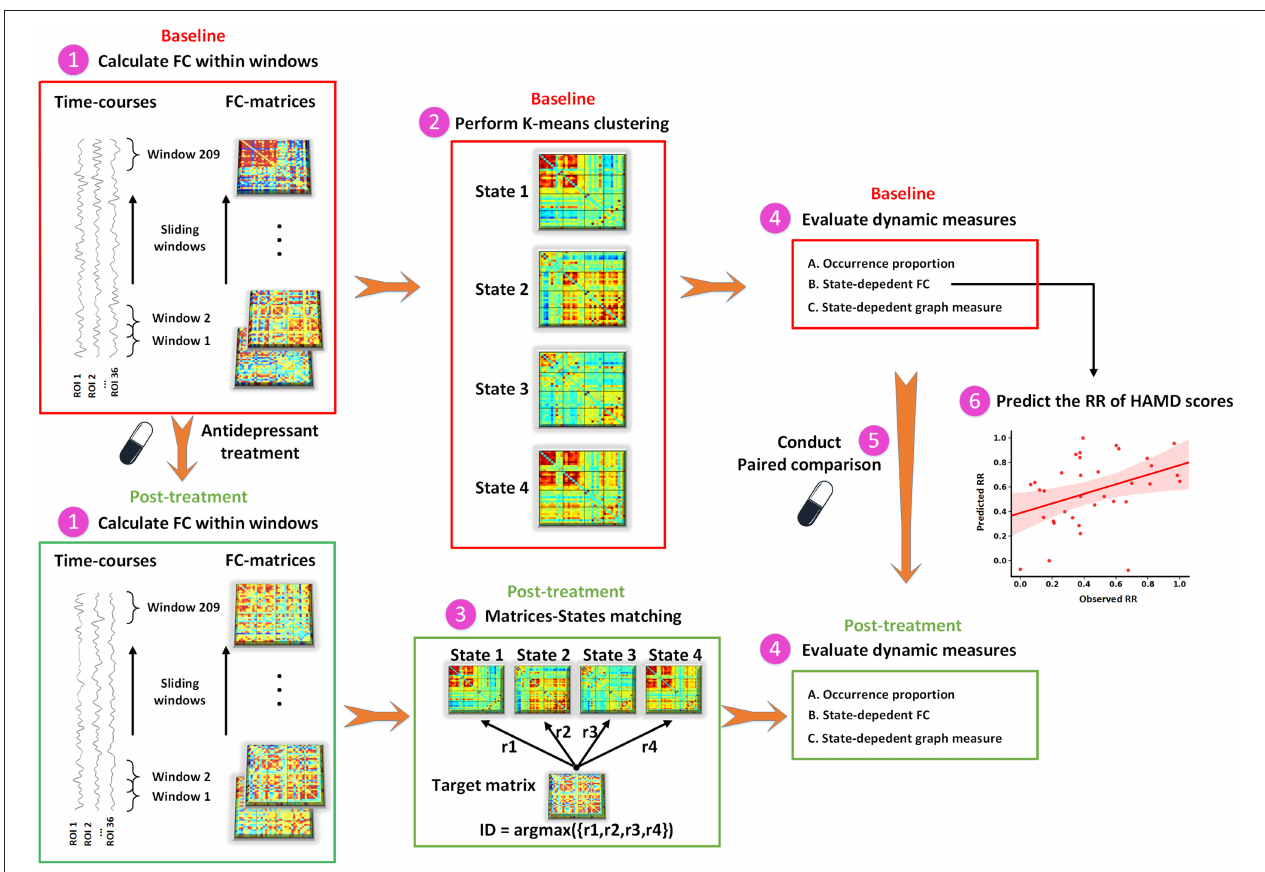
FIGURE 1 | The schematic diagram of dFC analysis. dFC, dynamic functional connectivity; FC, functional connectivity; HAMD, Hamilton Depression Rating Scale; ROI, region of interest; RR, reduction